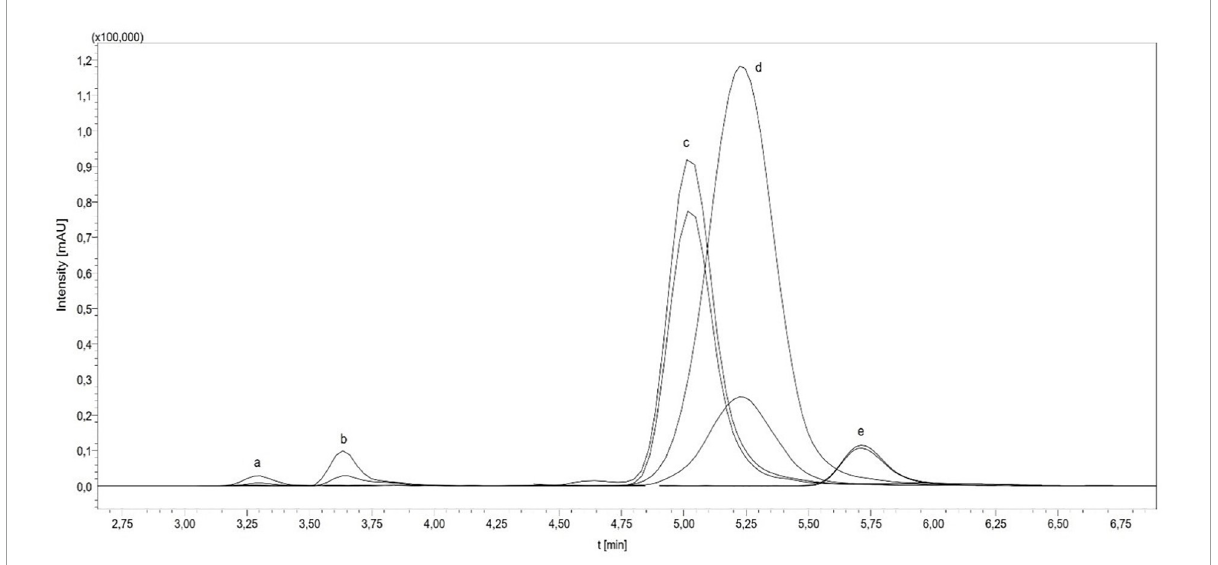
FIGURE3 LC-MS/MS chromatogram of Acheta domesticus [(a) H 4 folate, [ 13 C 5 ]-H 4 folate; (b) 5-CH 3 -H 4 folate, [ 13 C 5 ]-5-CH 3 -H 4 folate; (c) 10-CHO-PteGlu, [ 13 C 5 ]-10-CHO-PteGlu; (d) 5-CHO-H 4 folate, [ 13 C 5 ]-5-CHO-H 4 folate; (e) PteGlu, [ 13 C 5